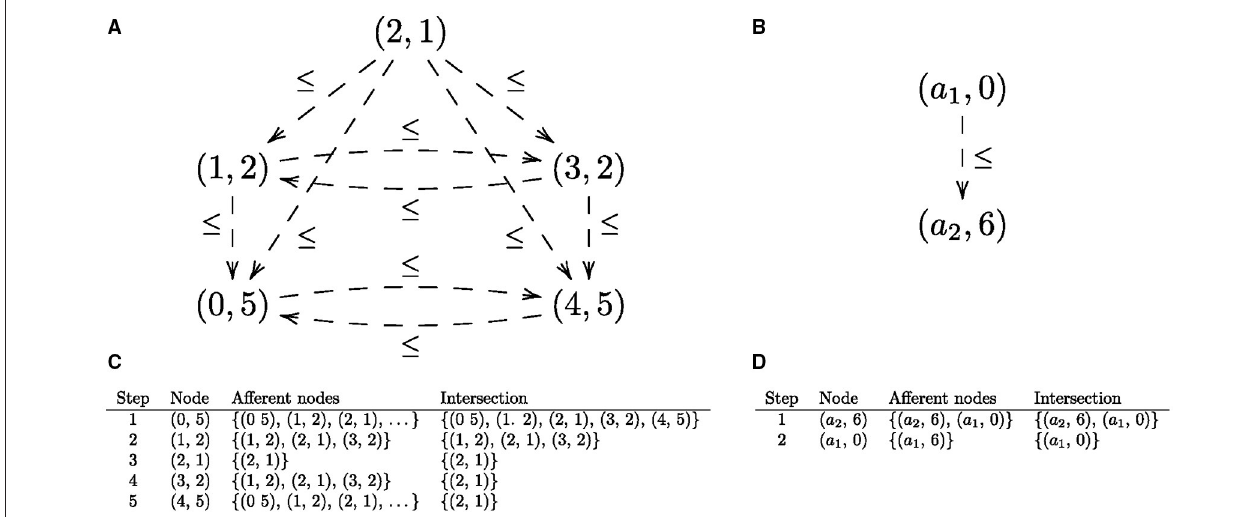
FIGURE 5 | (A) The comma category corresponding to the universal construction shown in Figure 3B as a directed graph. (B) The comma category corresponding to the universal construction shown in Figure 3D as a directed graph. Edges corresponding to identity arrows are not shown. (C,D) The iterative process for finding the initial nodes in corresponding directed